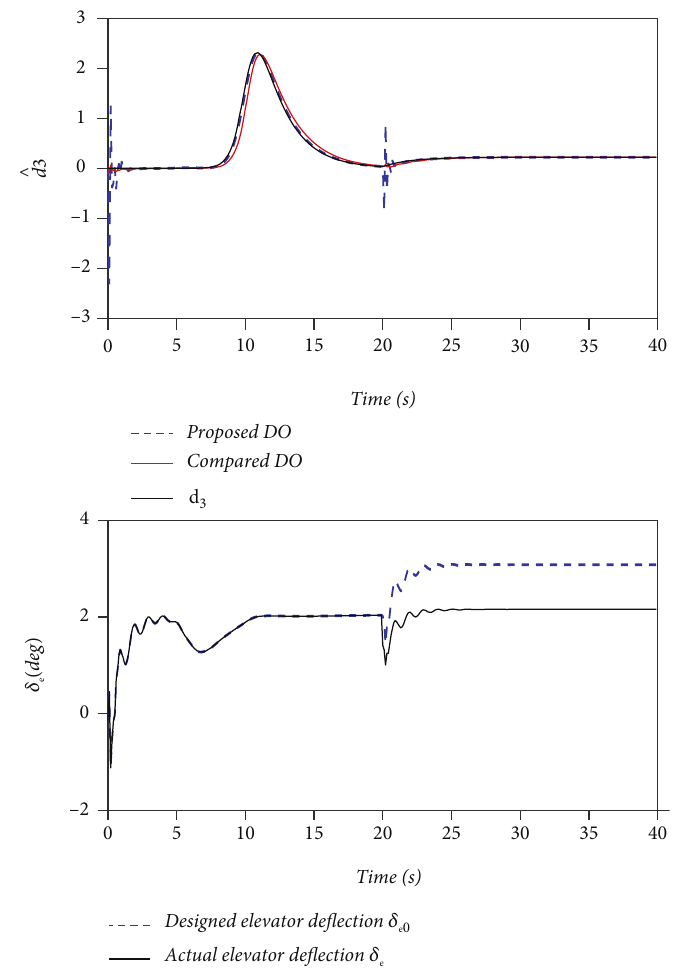
Figure 8: Estimation of d